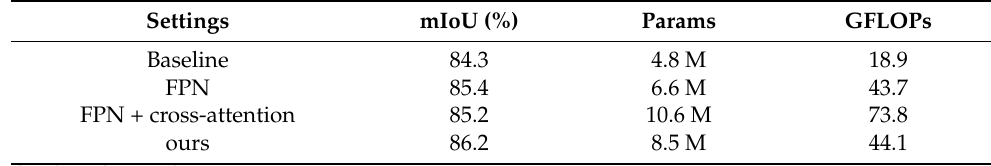
Table 2. Comparison with the FPN pixel decoder.